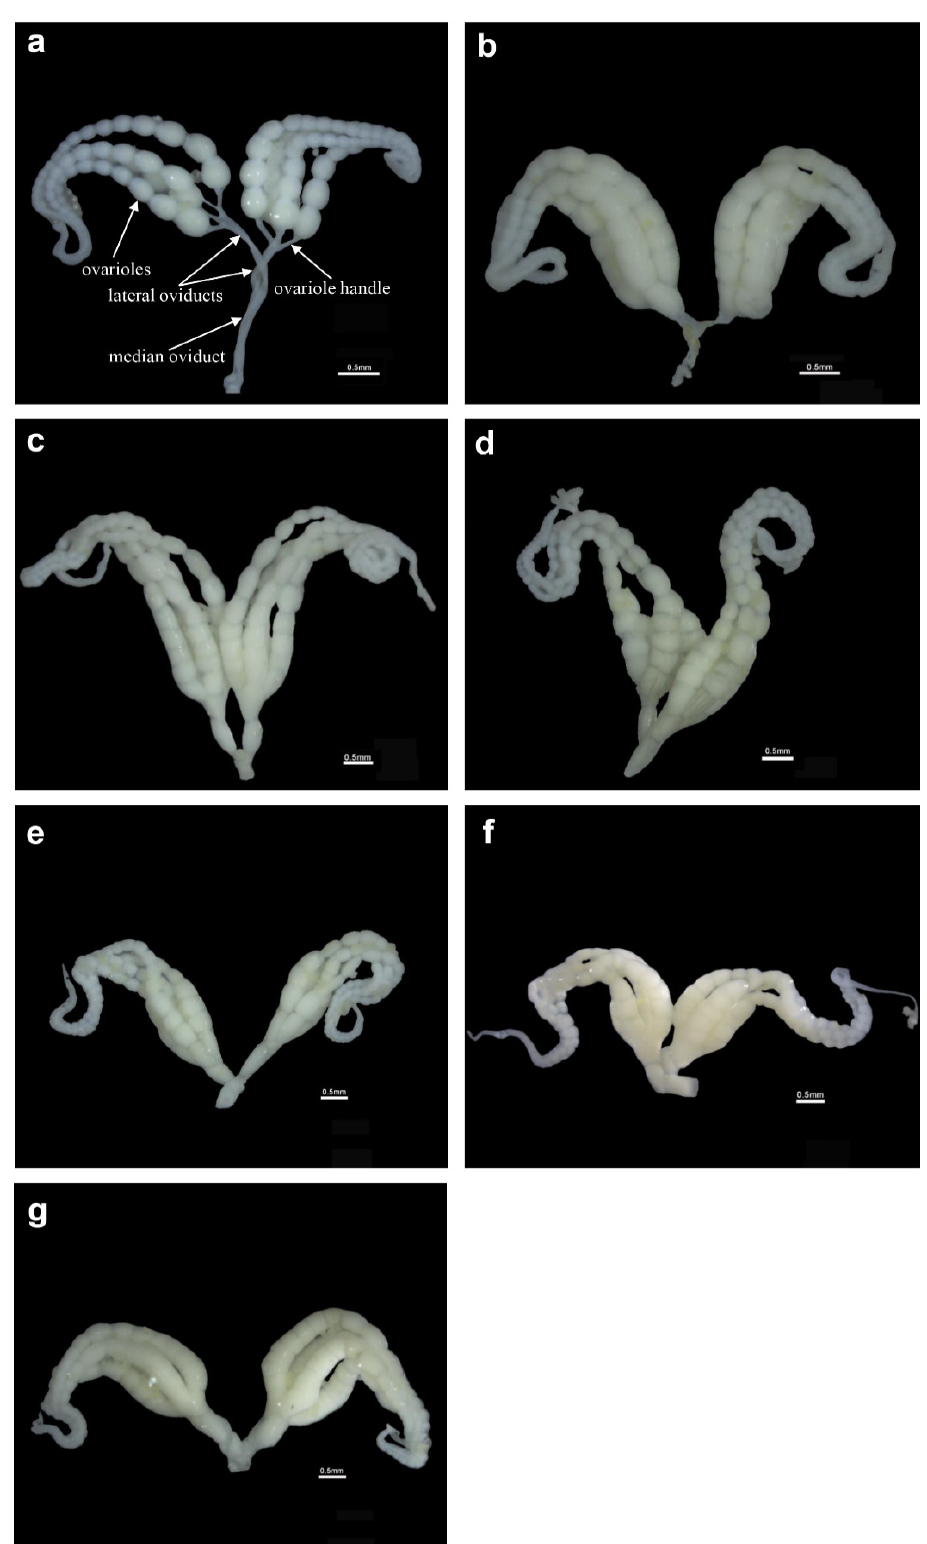
Figure 2. Ovarian development in Grapholita molesta females of different ages. ( a ) ovary of one-day-old female, ( b ) ovary of two-day-old female, ( c ) ovary of three-day-old, female, ( d ) ovary of four-day-old female, ( e ) ovary of five-day-old female, ( f ) ovary of six-day-old female, and ( g ) ovary of seven-day-old female. Bars = 0.5 mm. The structure of the ovary is marked with a arrow in Figure 2a.